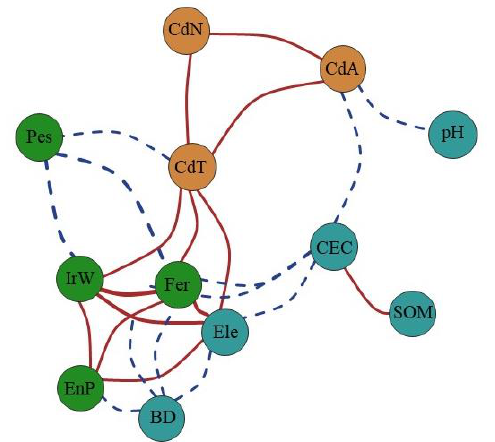
Figure 3. A co-occurrence network showing quantitative factors (note: CdT means total content of Cd in the soil, CdN means the content of Cd in rice, CdA means available Cd in soil, pH means soil pH, SOM means soil organic matter, CEC means soil cation exchange capacity, Ele means elevation, BD means bulk density, EnP means the density of enterprise, IrW means irrigation water, Pes means the amount of pesticide applied, and Fer means the amount of fertilizer applied).